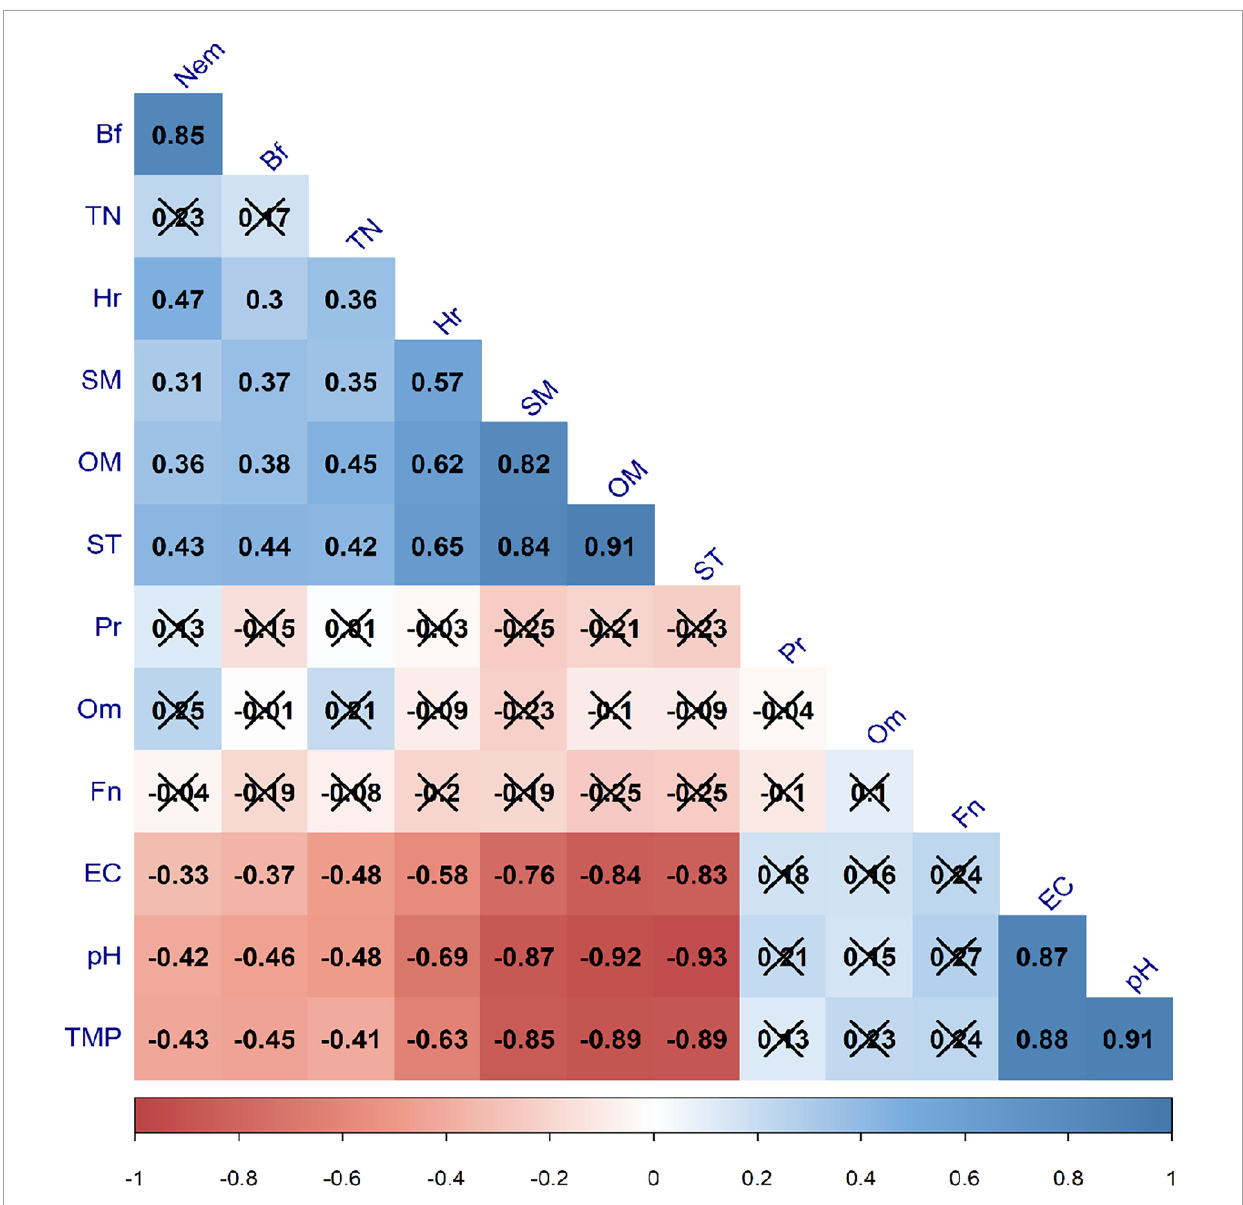
FIGURE5 Correlation between soil nematode trophic groups and soil physico-chemical properties. The cross marked correlation coefficients denote non-significance at p = 0.05. BF, bacterivores; Fn, fungivores; Hr, herbivores; Om, omnivores; Pr, predators; nem, total nematode abundance; EC, electrical conductivity; OM, organic matter; SM, soil moisture; ST, soil texture; TMP, temperature; TN, total